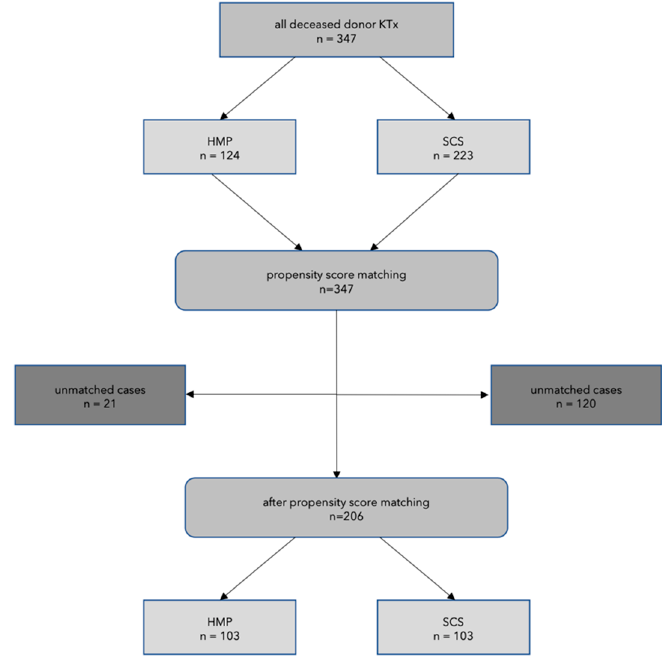
Figure 1. Flow chart of patient selection. HMP: hypothermic machine perfusion, SCS: static cold storage. Table 2. Baseline characteristics of the propensity-score matched cohort ( n = 206).